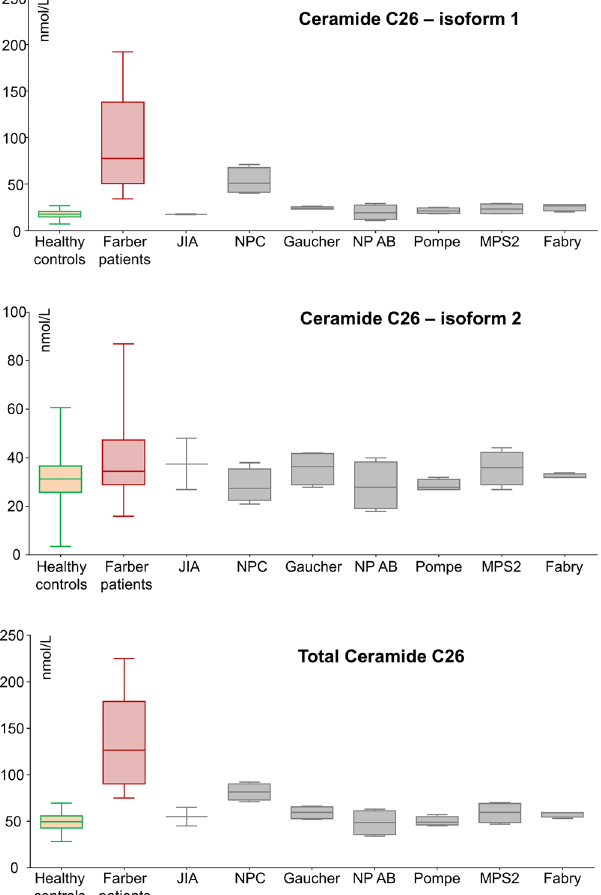
Figure 4. Box plots demonstrating levels of total C26:0 ceramide and its isoforms in the blood of NC, FP, JIA and patients affected by various LSDs. NC = heathy controls, FP = Farber patients, FC = Farber carriers.